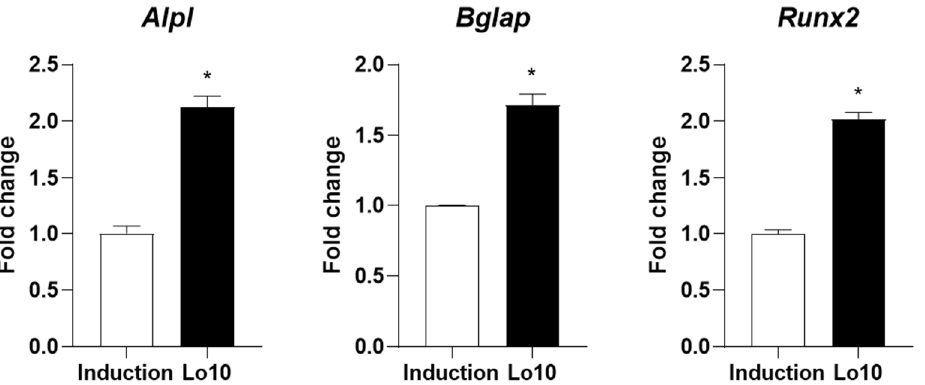
Figure 2. Effects of loganin on osteogenesis-specific markers in mouse preosteoblasts. MC3T3-E1 cells were incubated in osteoblast induction medium (50 μg/mL of ascorbic acid and 10 mM of β- glycerophosphate) with 10 μM loganin for 3 days. The mRNA expression levels of osteogenic markers including Alpl , Bglap, and Runx2 were determined by quantitative reverse-transcriptase polymerase chain reaction (qRT-PCR). Lo10: loganin 10 µ M. * p < 0.05 vs. induction (Student’s t